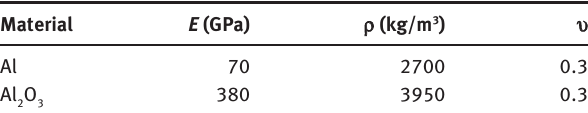
Table 1 Material properties of the constituents of the FG sandwich